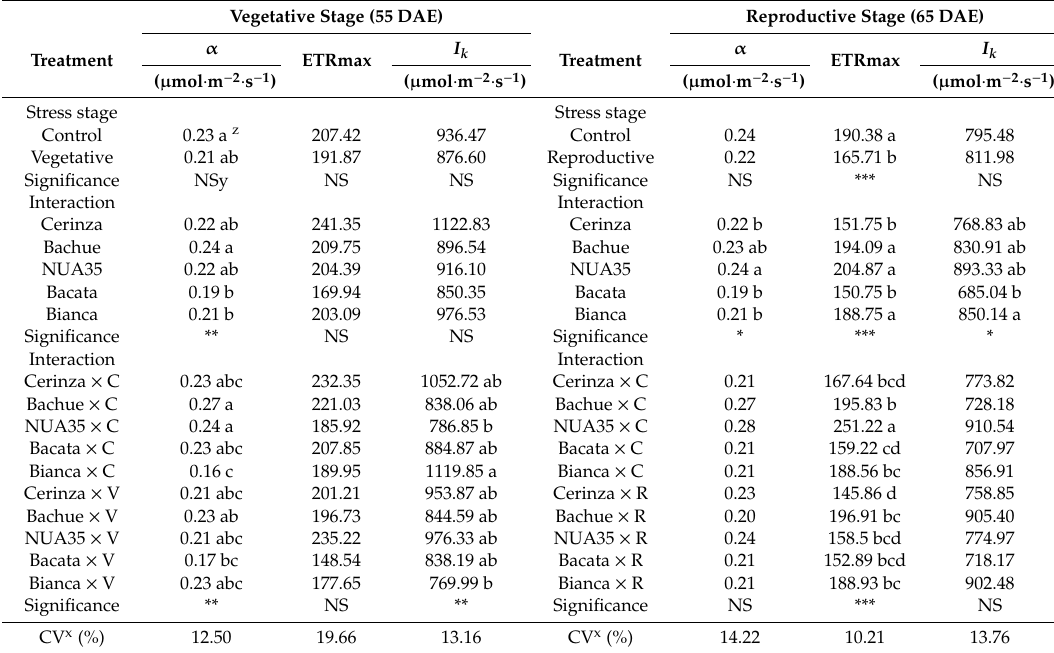
Table 3. E ff ect of the interaction between water stress and common bush bean ( Phaseolus vulgaris ) cultivars on the initial slope of the curve ( α ), maximum electron transport rate (ETR max ), and minimum saturation irradiance ( I K